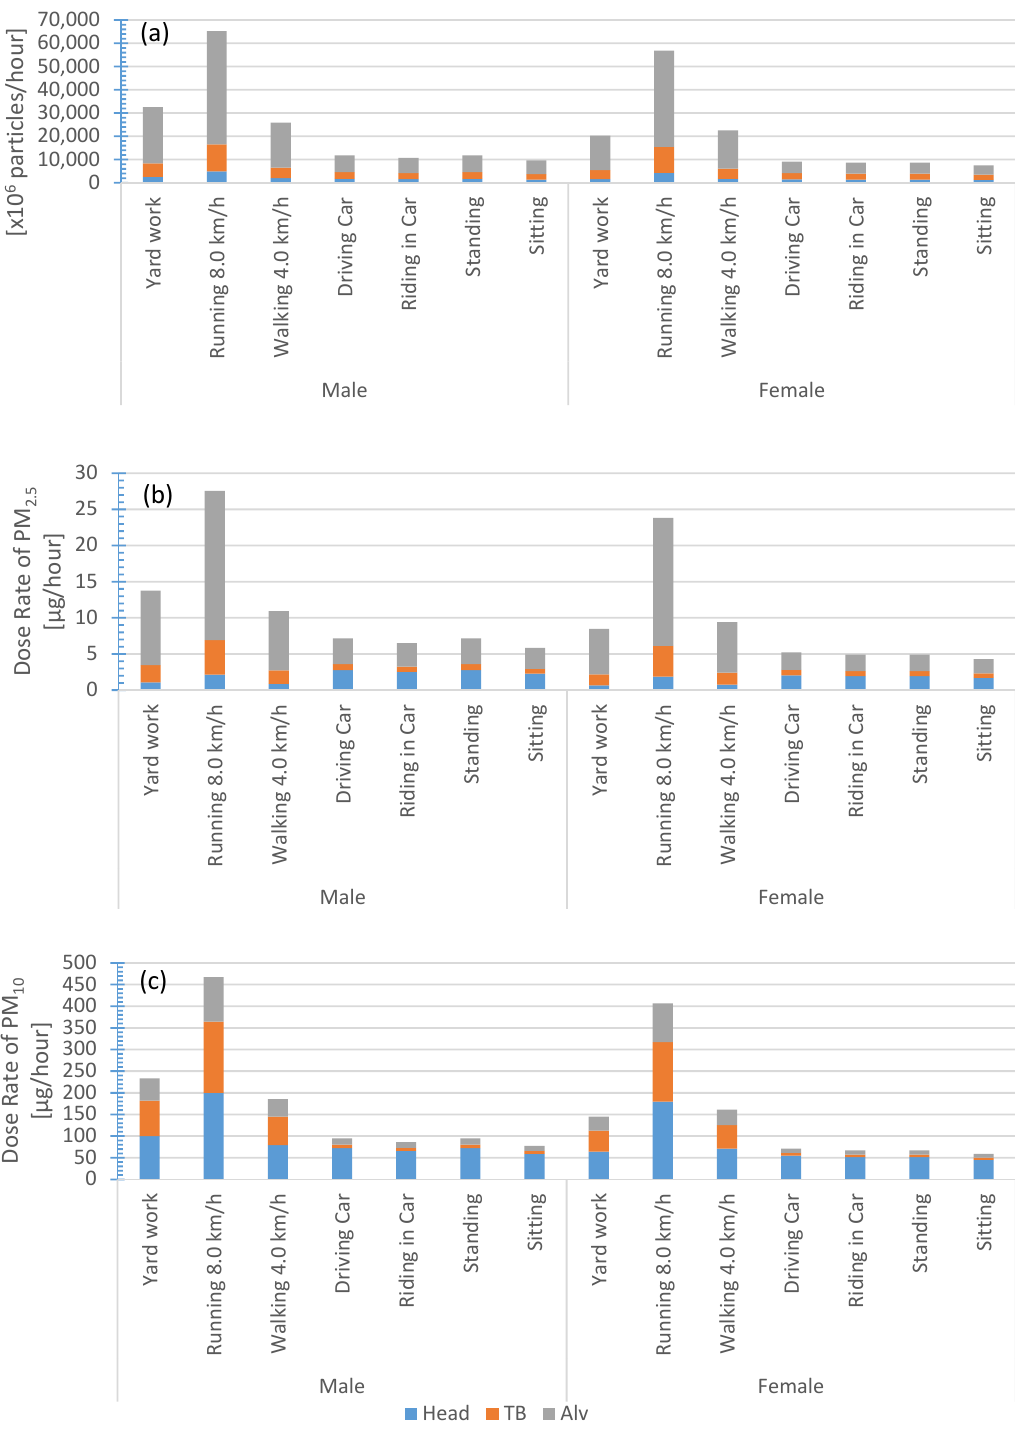
Figure 4. The rural background site; regional inhaled deposited dose rates calculated for di ff erent activities and genders: ( a ) submicron particle number concentration and ( b , c ) particulate matter PM 2.5 and PM 10 . The color legend is: (blue) head airways, (red) tracheobronchial, and (green)